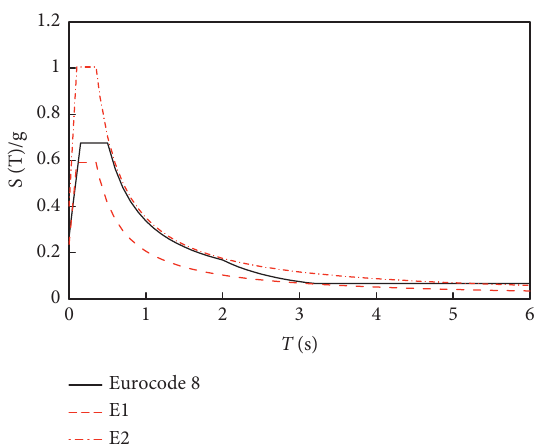
Figure 5: Comparison of horizontal design response spectra.